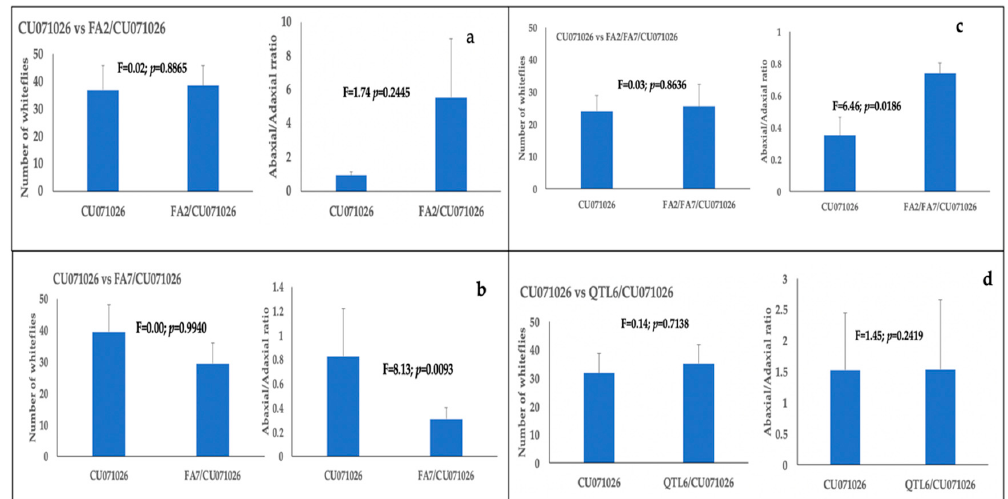
Figure 5. Bars with standard errors represent whitefly settling di ff erences between CU071026 and four other acylsugar-producing lines: ( a ) CU071026 vs. FA2 / CU071026; ( b ) CU071026 vs. FA7 / CU071026; ( c ) CU071026 vs. FA2 / FA7 / CU071026; and ( d ) CU071026 vs. QTL6 / CU071026. Bars with standard errors also represent ratios of whiteflies settling on adaxial and abaxial leaf surfaces of each leaf placed in the settling arena. Whitefly counts were made 24 h after